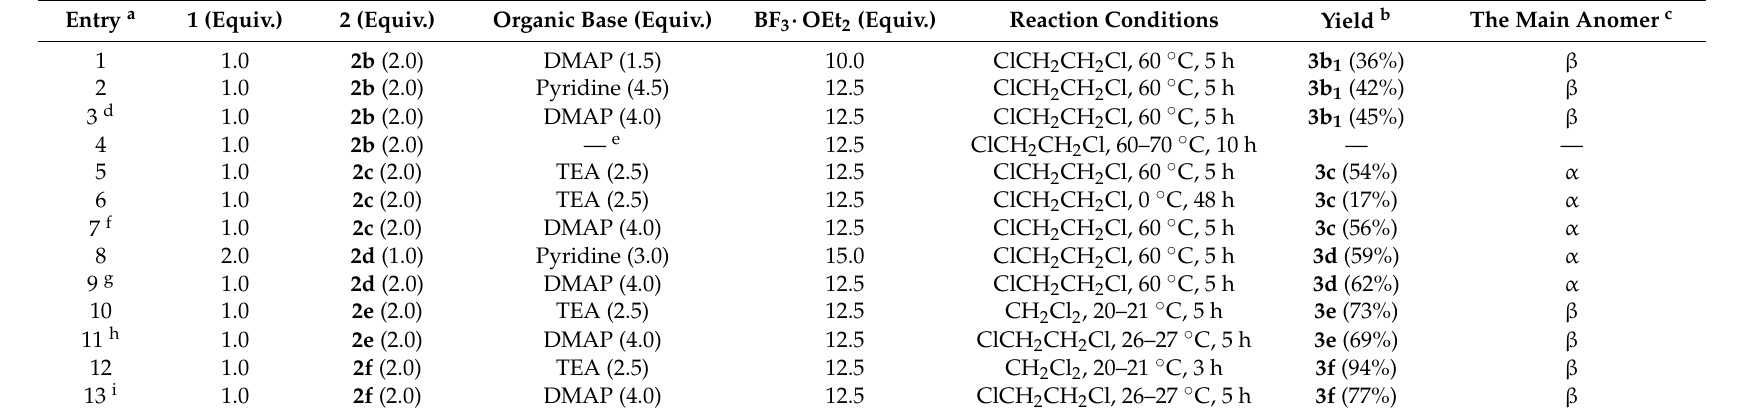
Table 3. Glycosylation of 4-MU ( 1 ) with other peracetyl sugars ( 2b – 2f